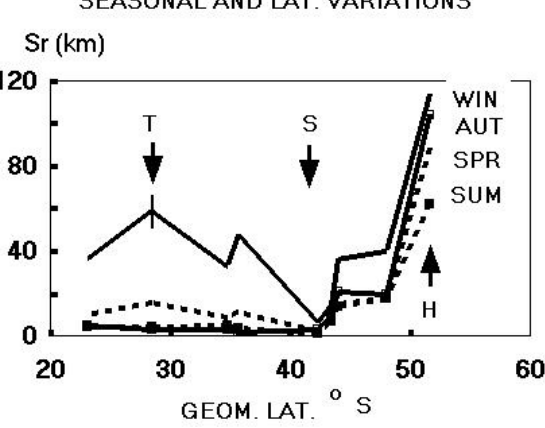
Fig. 5. Latitudinal cross-sections of the mean range spread-F at dif- ferent seasons. The geomagnetic positions of the stations for which maxima (Townsville-T and Hobart-H) and a minimum (Sydney-S) were observed are shown by the arrows. A typical example of the standard error is